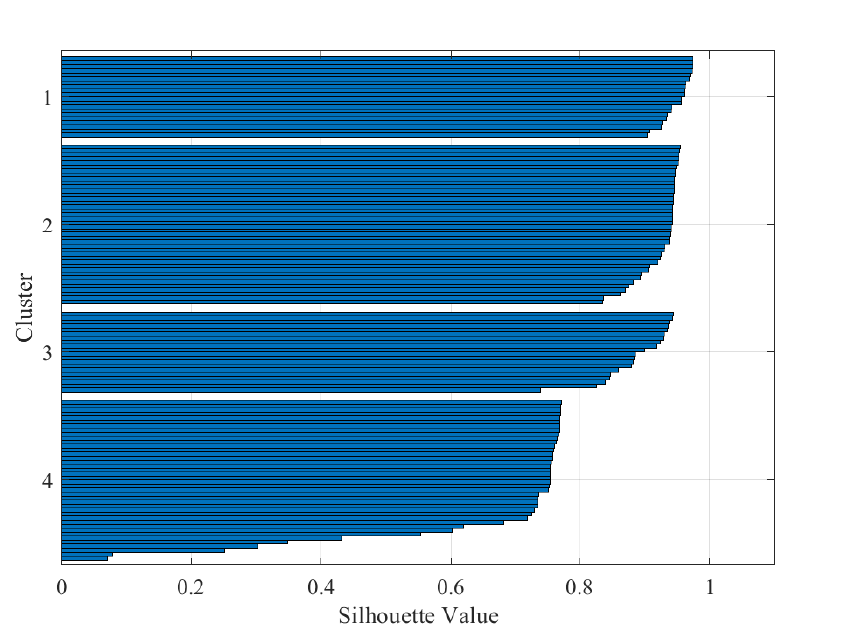
Figure 17. Silhouette plot of combined stator voltage and current, and rotor current harmonics data with k = 4.